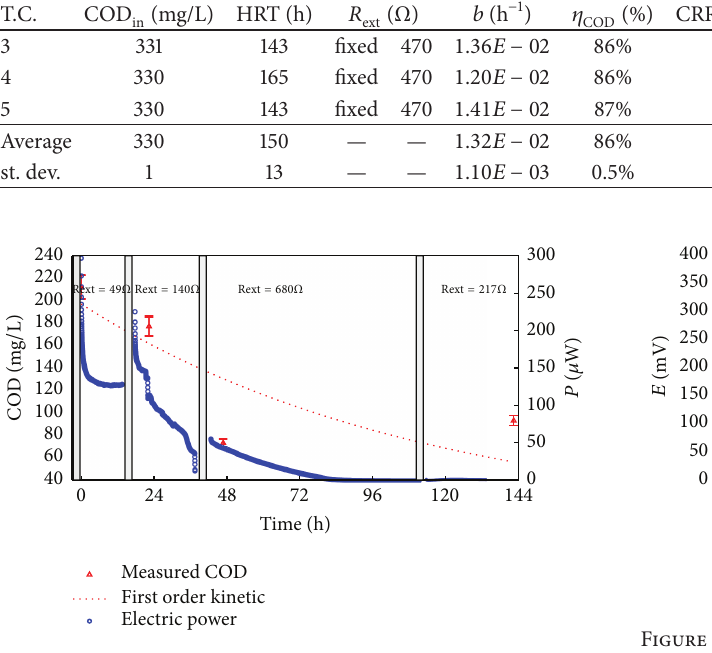
Figure 4: Continuous monitoring of treatment cycle 1. Grey bars are placed in correspondence of polarization curve measurements.